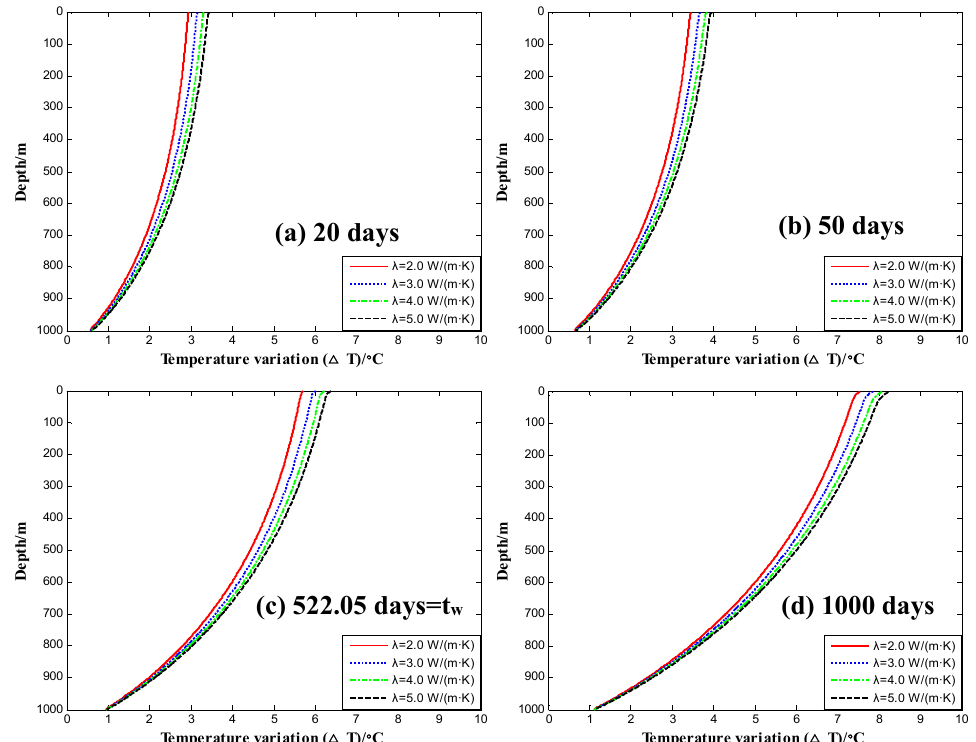
Figure 17. Overburden temperature variation at the wellbore-formation interface ( r = 0.14 m, 0 m ≤ z ≤ 1000 m) with different thermal conductivity (TC). ( a ), ( b ), ( c ), ( d ) are the temperature profiles of 20, 50, 522.05, 1000 days of production time, respectively.